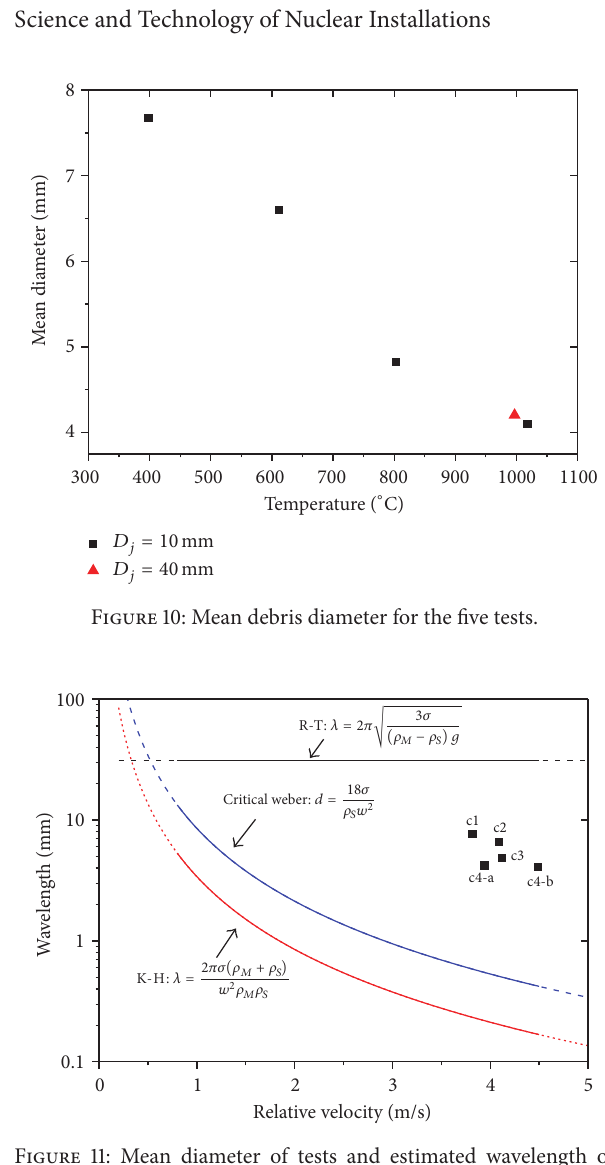
Figure 11: Mean diameter of tests and estimated wavelength of